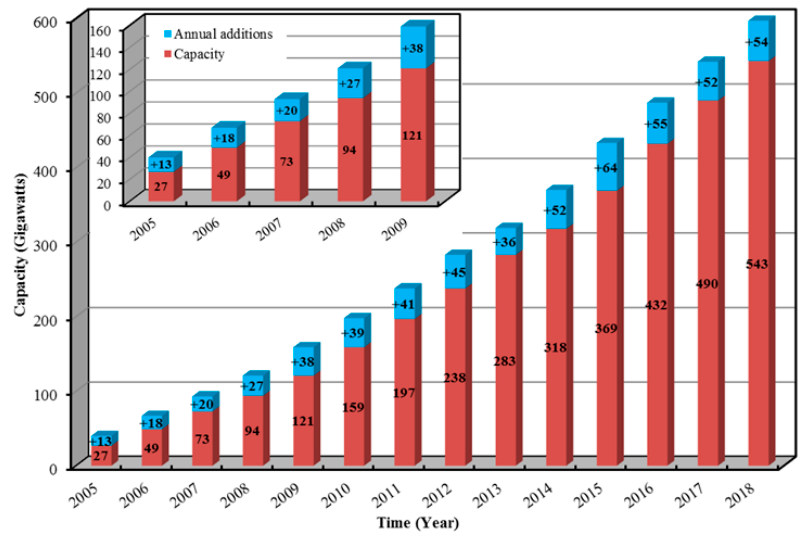
Figure 1. Wind Power Global Capacity versus Annual Additions, for the period 2005–2018.